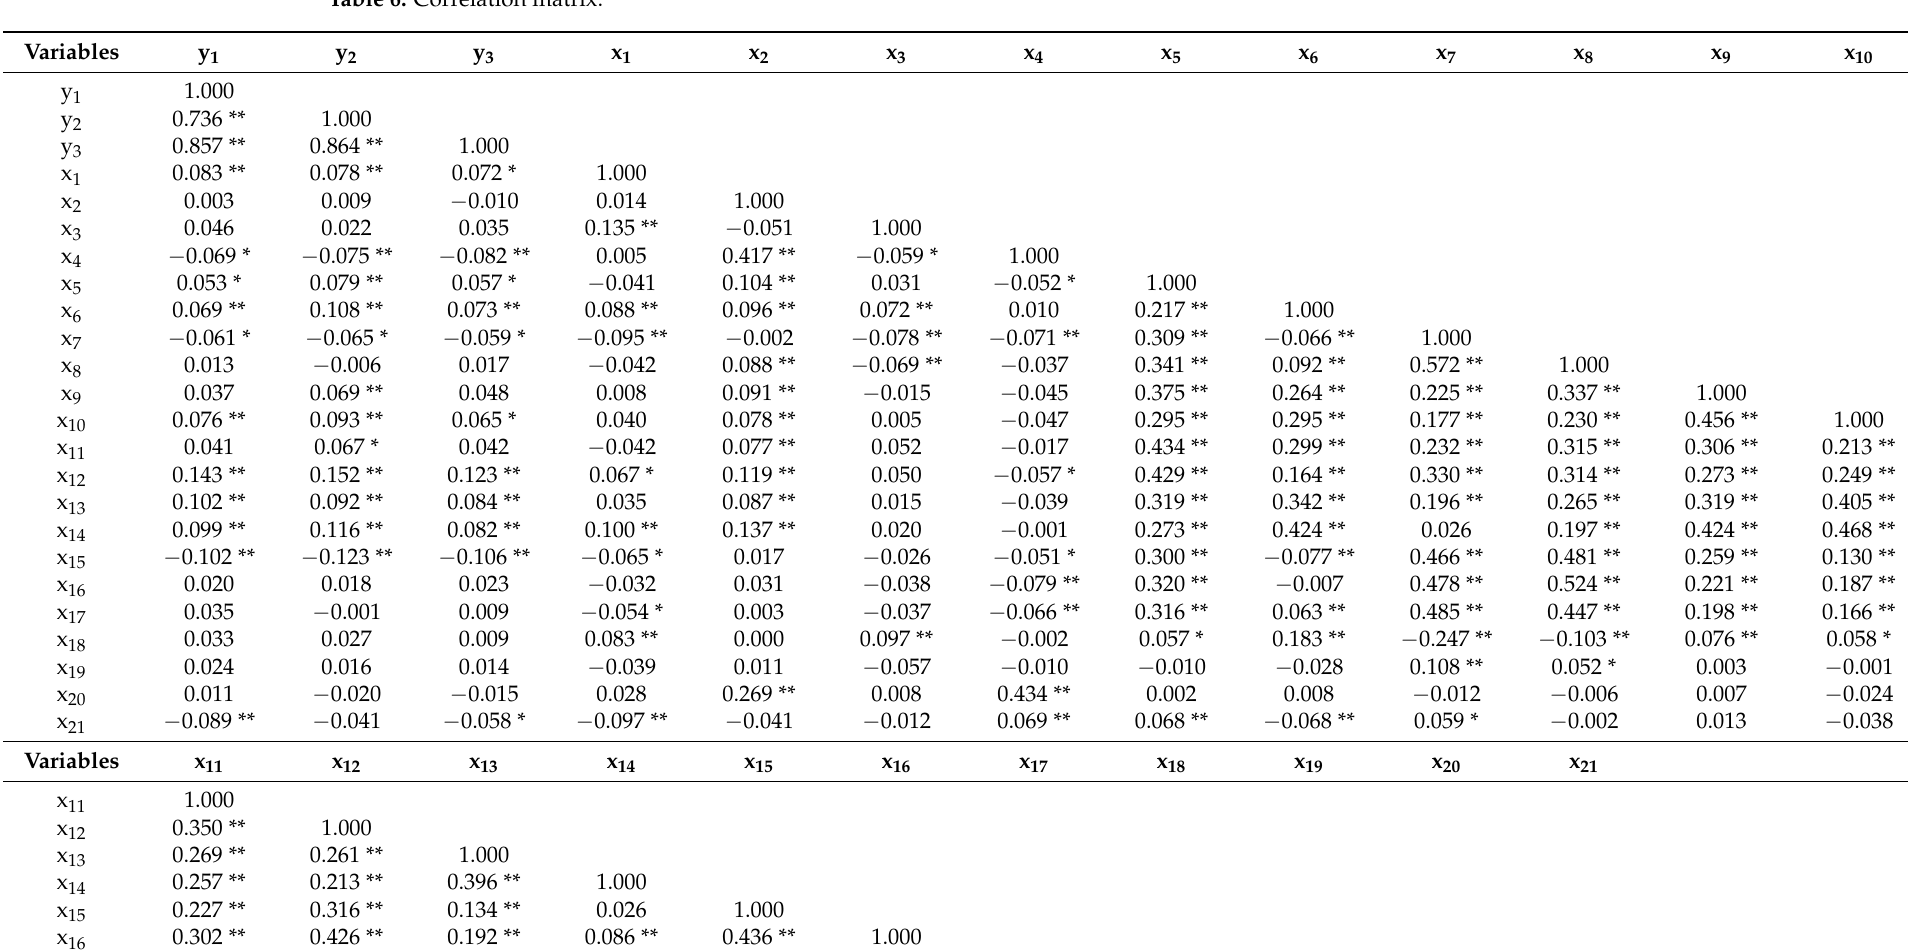
Table 6. Correlation